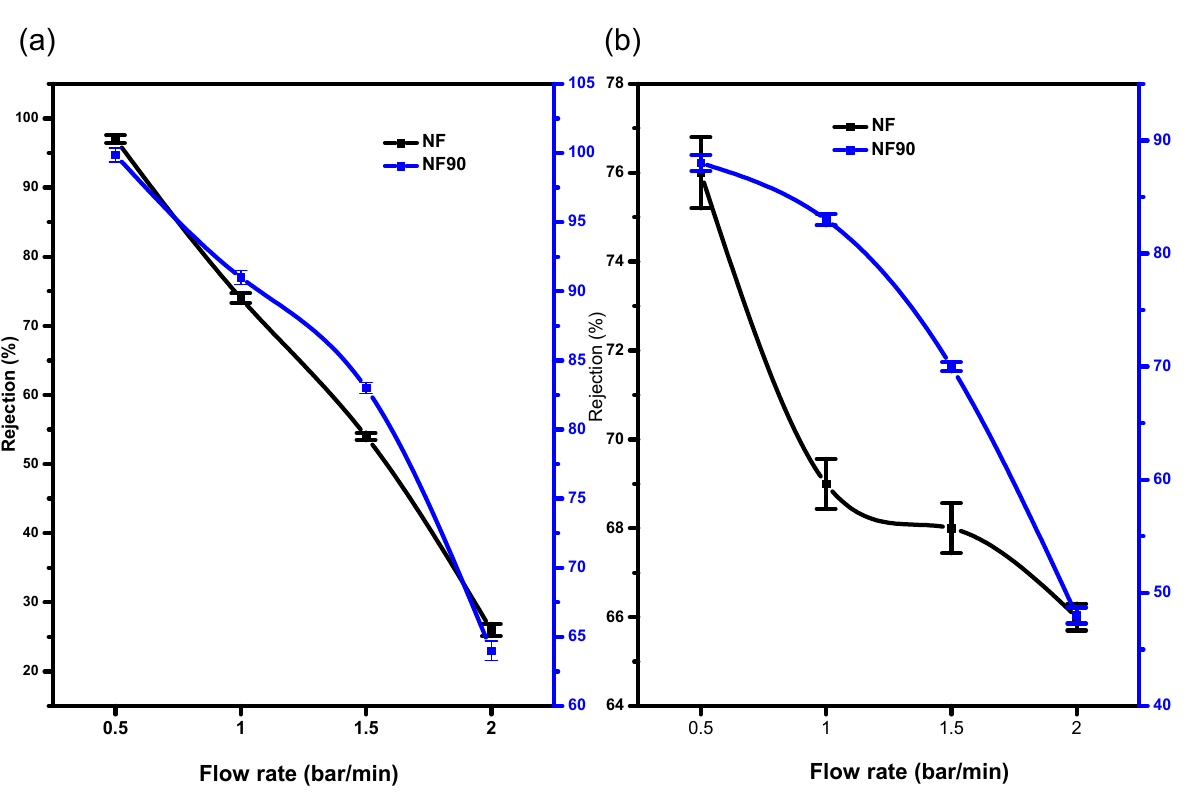
Figure 9. ( a ) Percentage rejection of Ni 2+ ( b ) Cu 2+ binding to (Na 2 EDTA) on Cu/Ni/EDTA at 20 ppm and pH 2 with chelating agent.